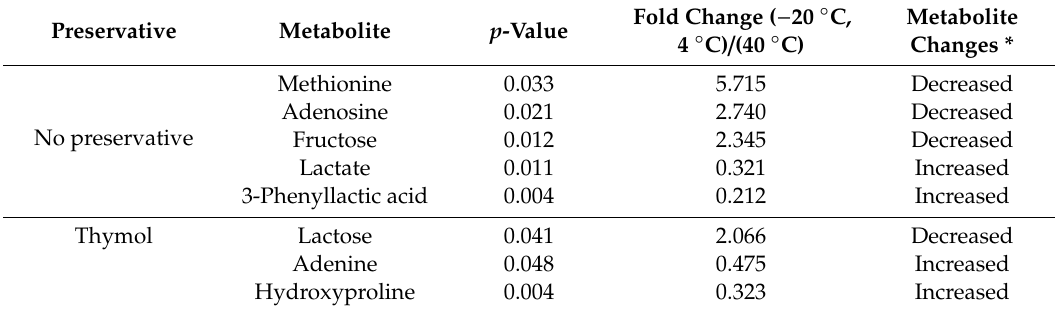
Table 4. Significantly altered metabolites at high temperature (40 ◦ C) in urine samples with no preservative or preserved with thymol in the No PABA